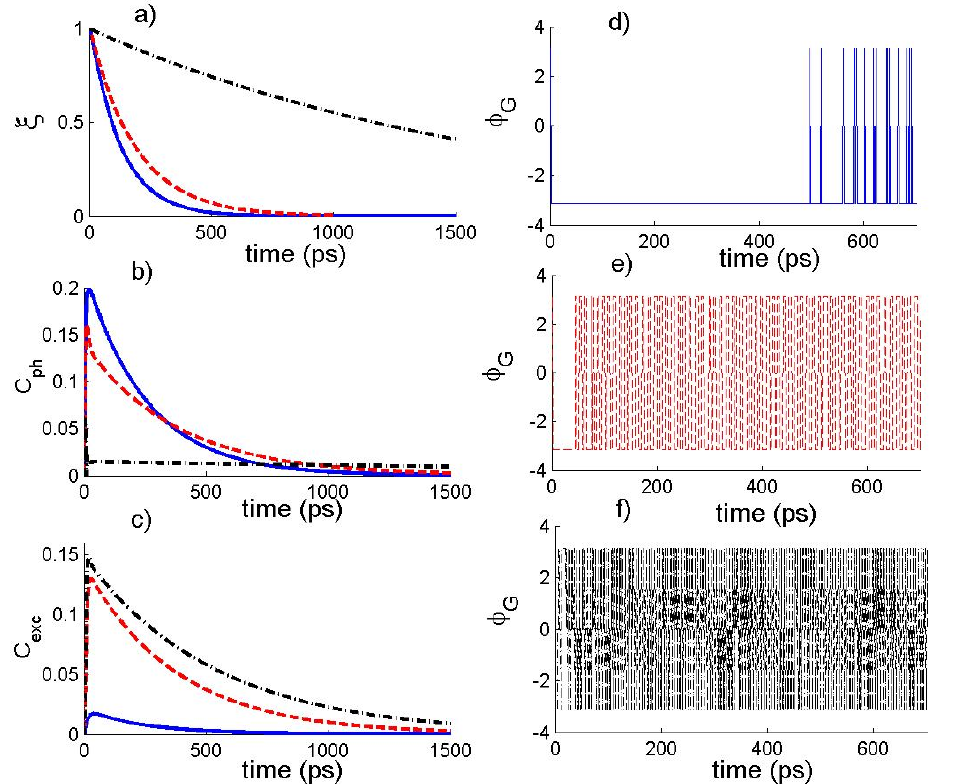
Figure 1. The temporal behavior of the ( a ) state fidelity ξ ( t ) , ( b ) photons state coherence C ph ( t ) , ( c ) exciton-state coherence C exc ( t ) and ( d – f ) the total phase φ G of the photon–exciton state for α = 10 − 8 , ( κ , γ ) = ( 0.2,0 ) , ε = 0.01 κ , where g = 0.01 (solid curve), g = 0.1 (dashed curve), and g = 0.5 (dash-dotted curve).